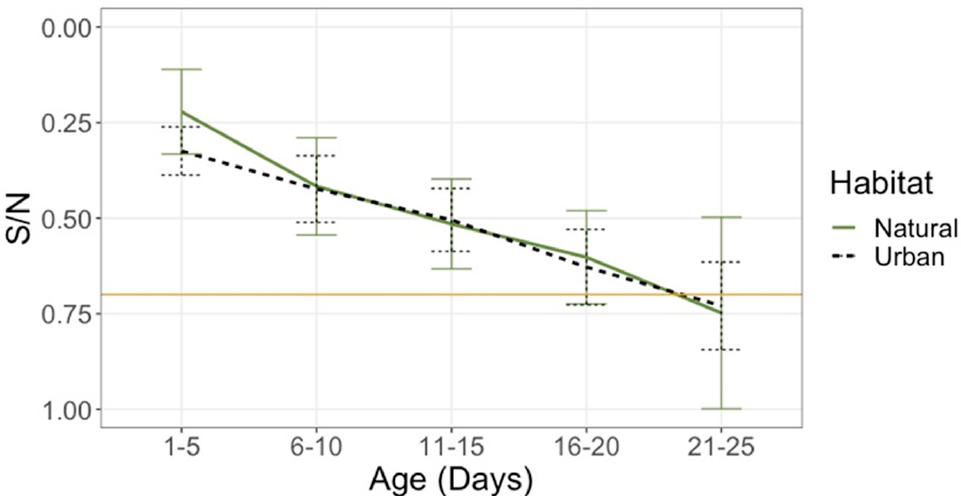
Figure 2. The persistence of avian influenza virus (AIV) antibodies in ibis nestlings. Average sample to negative (S/N) ratio for plasma samples (urban n = 1 63; natural n = 66) from 2020 and 2021 in a south Florida urban rookery (black dotted) and from the 2021 breeding season in natural rookeries (green solid). Error bars represent a standard error calculation. The higher S/N ratio reflects the lower concentration of AIV antibodies.